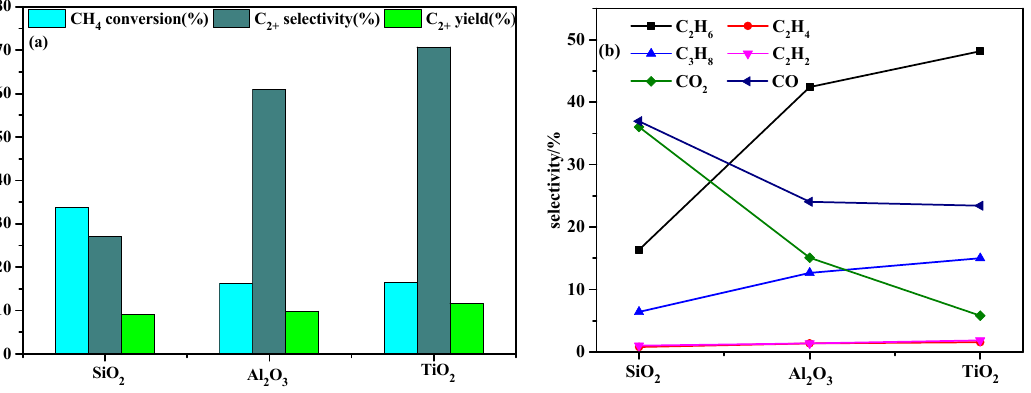
Figure 2. Performance of different dielectric materials in DBD plasma. ( a ) Oxidative coupling performance; ( b ) product distribution (temperature: ambient temperature, flow rate: 60 mL/min, applied voltage: 100 V).